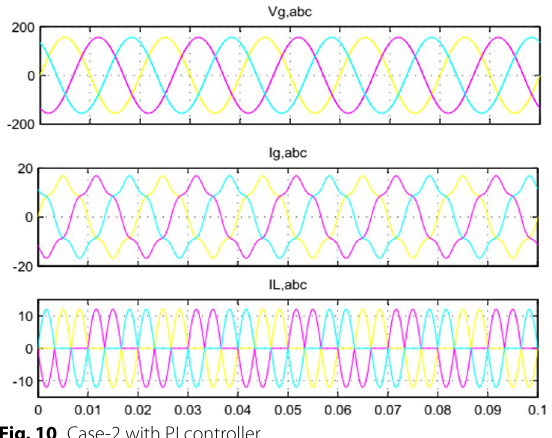
Fig. 12 Case-2 with fuzzy controller